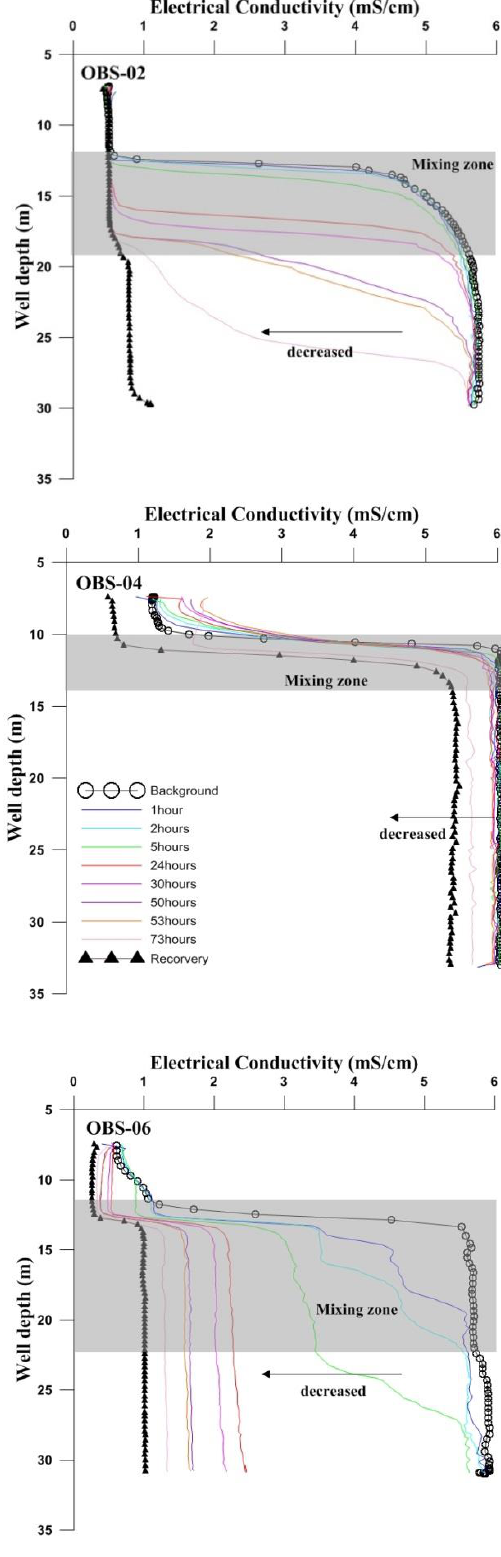
Figure 12. Changes in the vertical profiles of temperature and EC values at the observational wells during the pumping test.